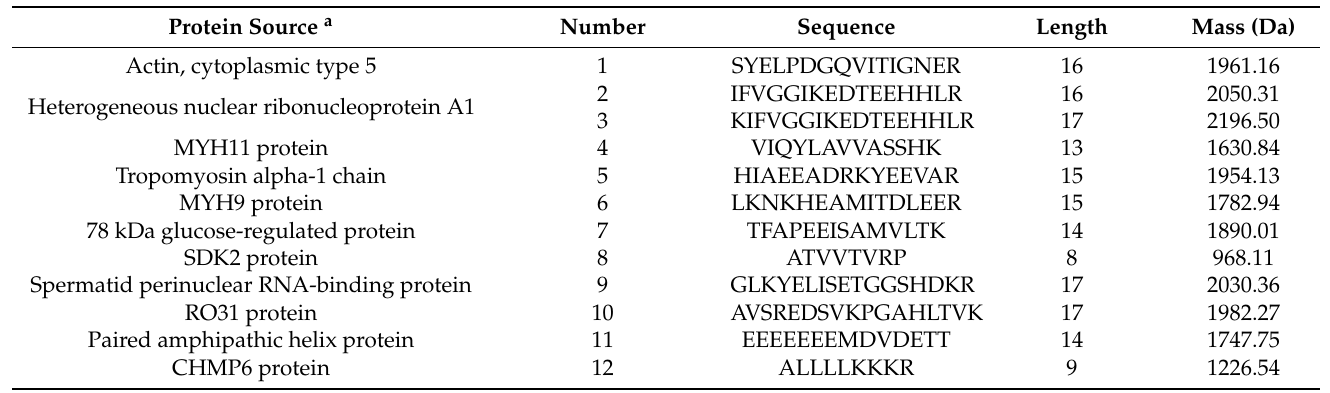
Table 5. The peptide sequences of the P2